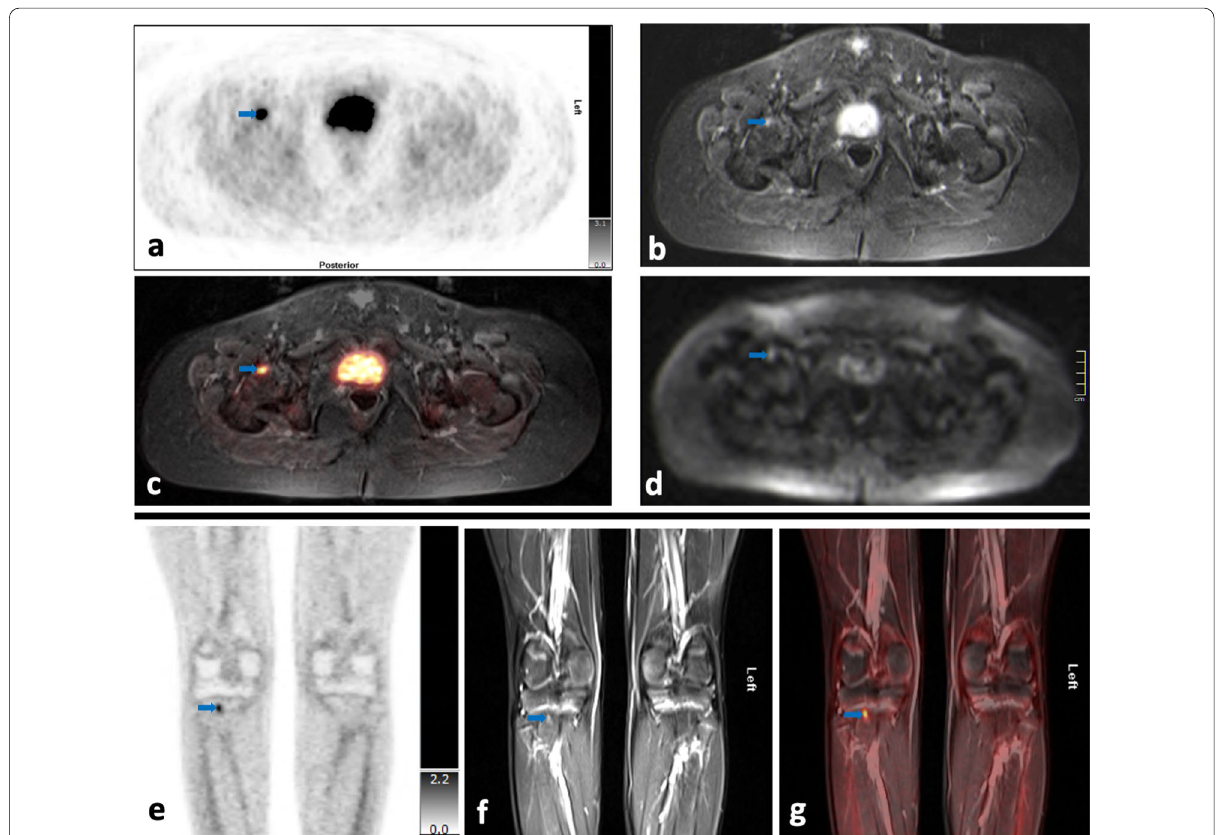
Fig. 7 a–g Upper double row: Small focus of skeletal involvement in the right femoral head which has increased glucose metabolism on [ 18 F]‑FDG‑PET images (SUV max 5.98) ( a, c ), is hyperintense on MR T2‑TIRM images ( b ) and shows restricted diffusion on DWI ( d ). Lower row: Small focus of skeletal involvement in the right proximal tibia which has moderately increased glucose metabolism on [ 18 F]‑FDG‑PET images (SUV max 2.18) ( e, g ) and is slightly hyperintense on MR T2‑TIRM images ( f